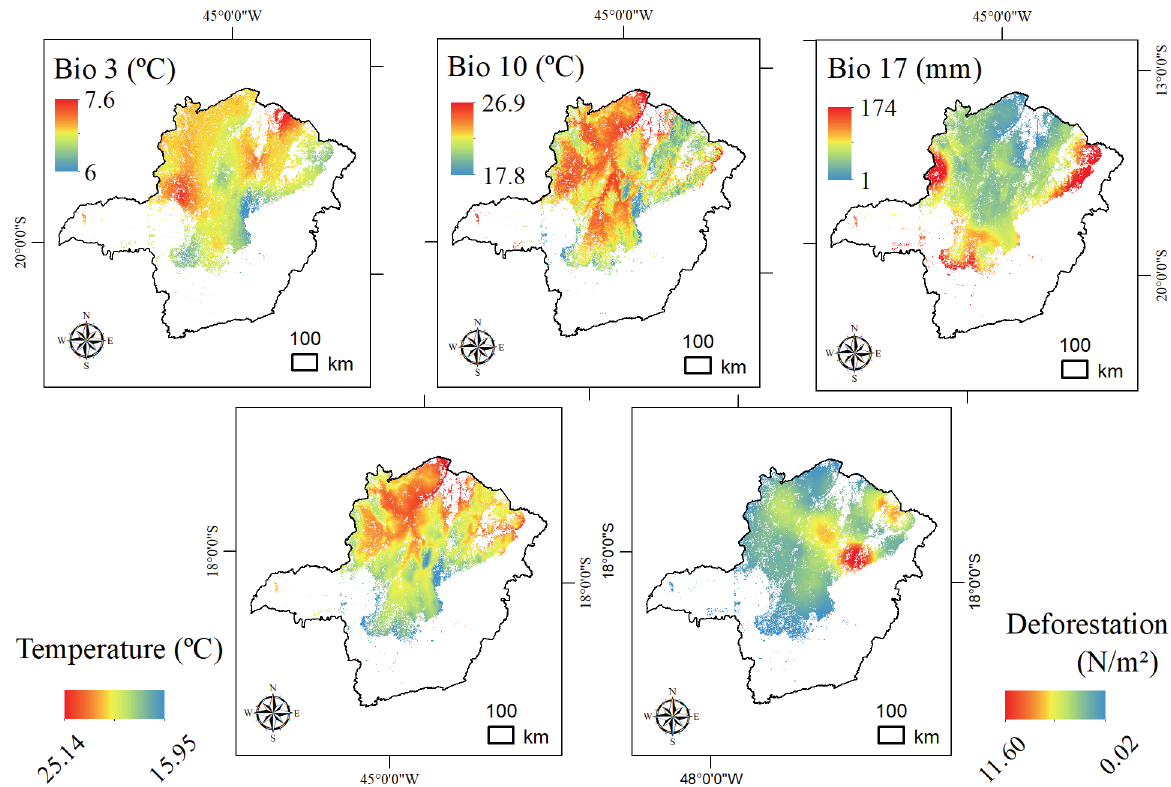
Figure 3 - Selected variables by multivariate regression model for wood volume estimation: Bio 3= Isothermality; Bio 10 = Mean Temperature of Warmest Quarter (ºC); Bio 17= Precipitation of Driest Quarter (mm); Temp=Annual Mean Temperature and Dd= Deforestation density.